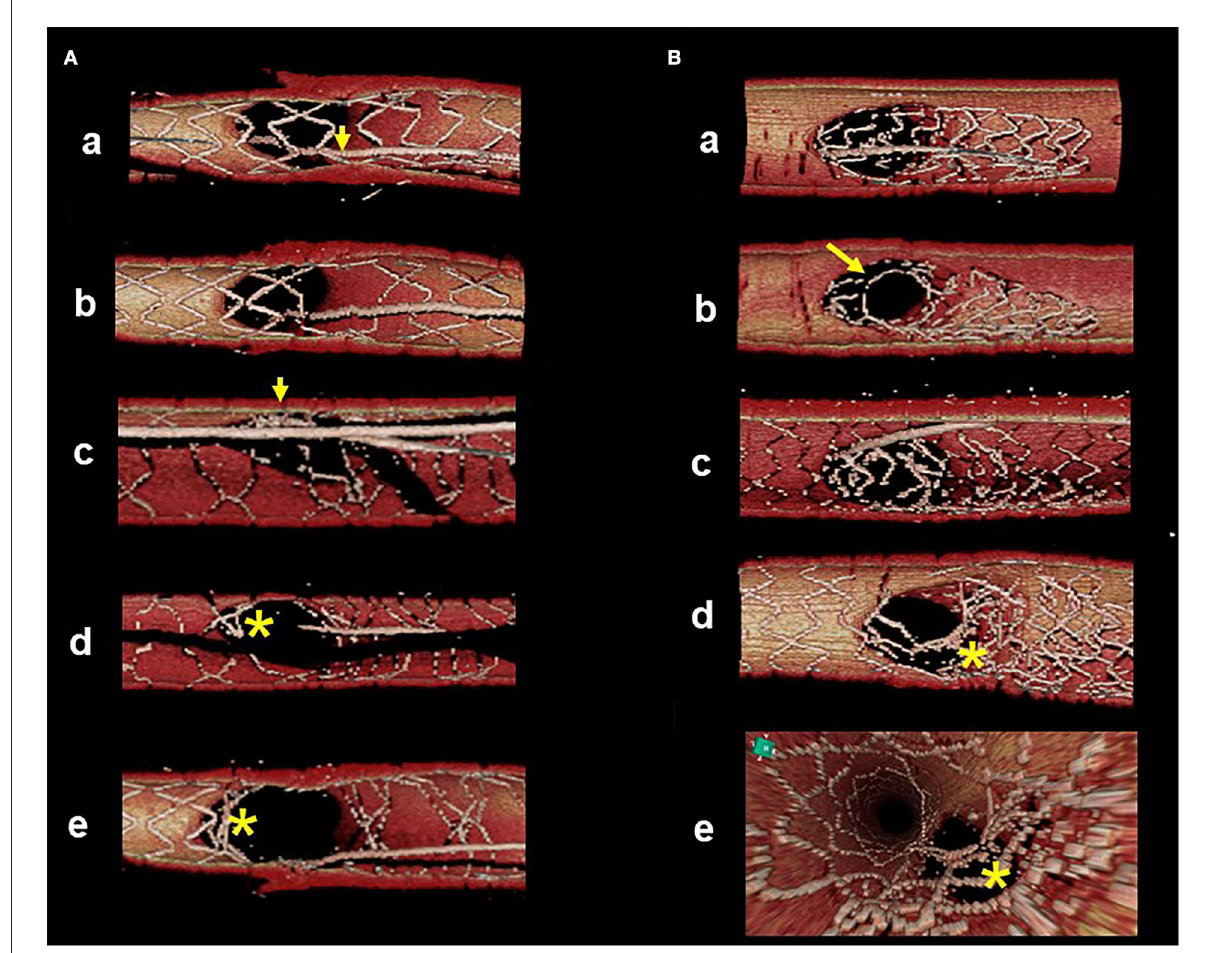
FIGURE4 Suboptimal guidewire recrossing in 2-stenting under angio-guidance. 3D optical coherence tomography (OCT) imaging was post-hoc analysis. (A) Culotte stenting. First guidewire recrossing to the main vessel (MV) is in the proximal cell (a, arrow) and subsequent MV dilation left jailing struts at the carinal site (b). After MV stenting, second guidewire recrossing to the side branch (SB) is optimal in the distal cell (c, arrow). Even after final kissing balloon inflation (KBI), metallic carina remains as the asterisk indicates (d: view from MV, e: view from SB). (B) Double kissing (DK)-crush stenting. After SB stent crush, first guidewire recrossing to the middle part of SB (a). First KBI made the hole in the proximal site (b). After MV stenting, second guidewire recrossing outside of the hole made by first KBI (c, recrossing point is indicated by the arrow in b ). Even after second KBI, distorted struts are clustered in the proximal part of the SB ostium, indicated by the asterisk (d: view from MV, e: view from proximal to the